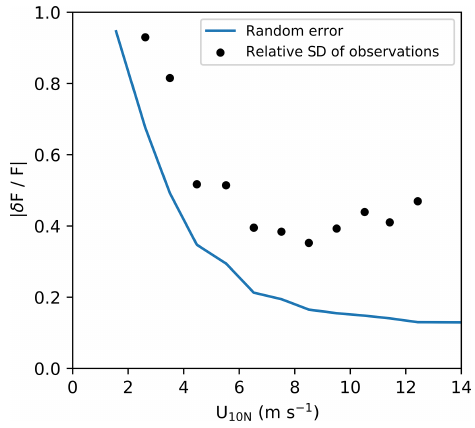
Figure 5. Relative random uncertainty in hourly CO 2 flux and its contribution from noise, vertical flux, and other processes during two Arctic cruises. Relative random uncertainty data are binned into 3mmolm − 2 d − 1 flux magnitude bins (error bars represent 1 stan- dard deviation).